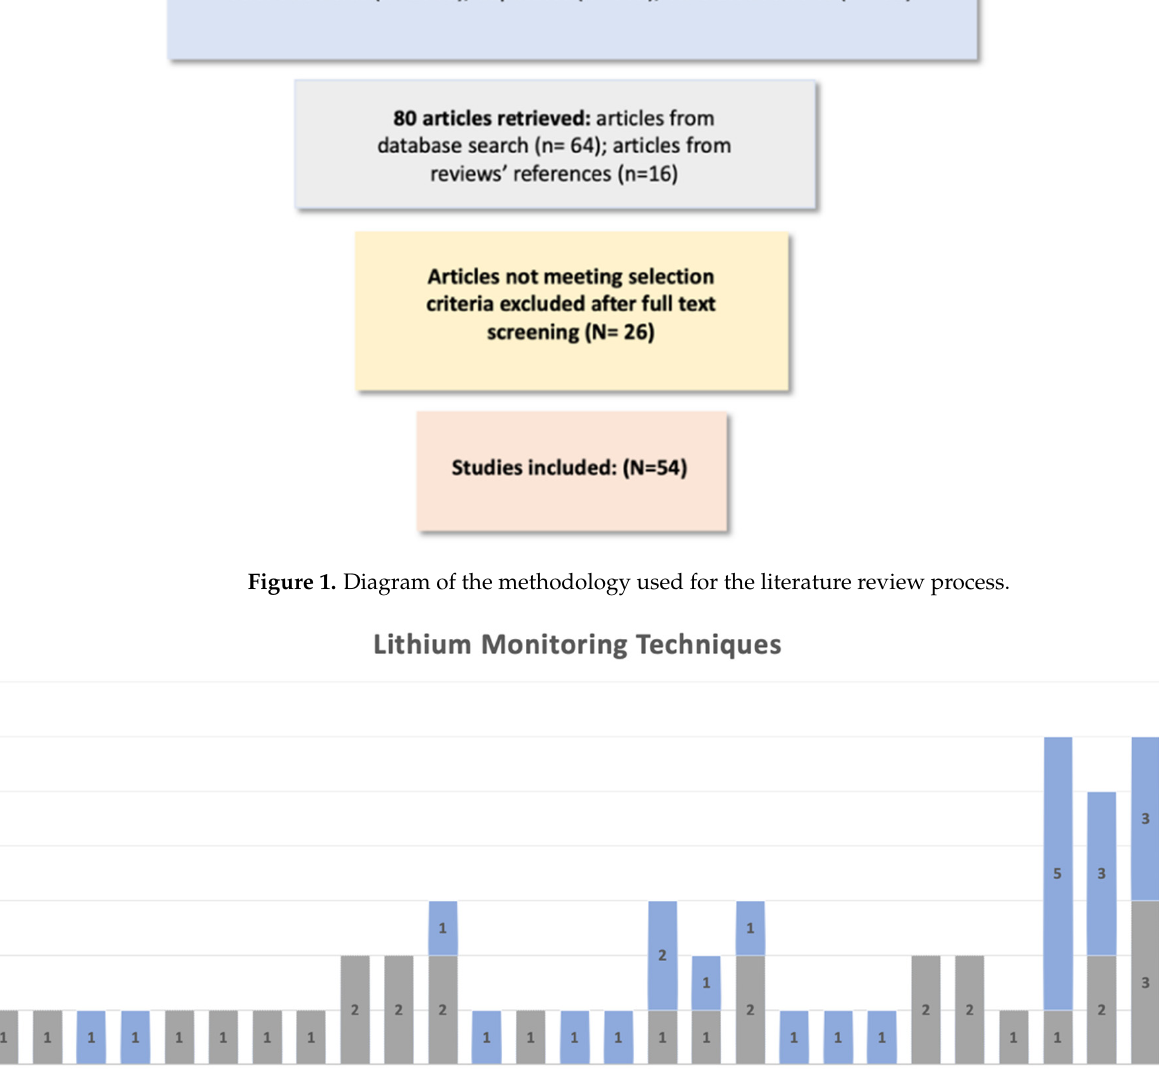
Figure 2. Number of publications investigating lithium therapeutic monitoring systems from 1967 to 2021.